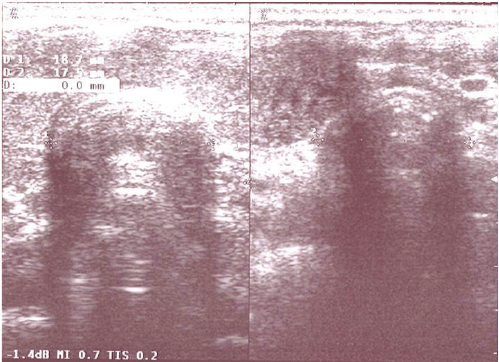
Figure 2: Neck and thyroid ultrasound examination (Case 2): trachea with a reduction of the transverse diameter (17.5mm) in the distal cervical tract and dislocation to the left of the